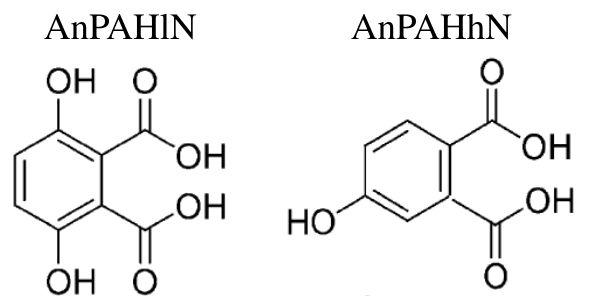
Fig. 1. Molecular structures of AnPAHlN and AnPAHhN used as surrogates for SOA formation from naphthalene and alkylnaphtha-